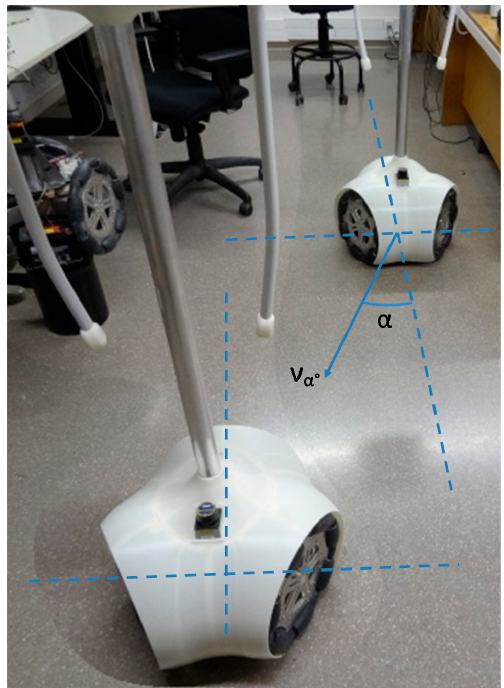
Figure 19. Composite image created to show the relative displacement of the mobile robot originated by wheel velocity profile of Figure 18. The APR maintains the absolute angular orientation.